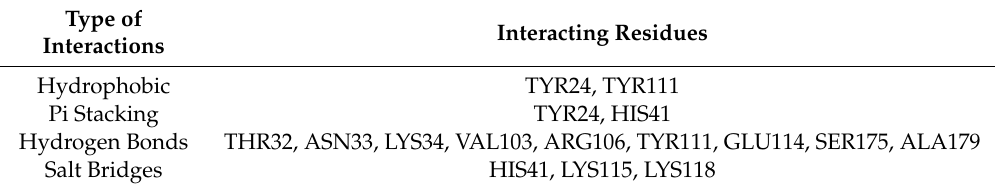
Table 2. Main interacting residues between top BD pose and H3N2 endonuclease.